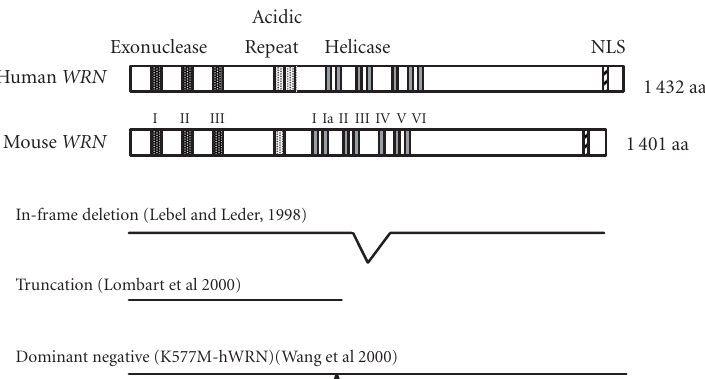
Figure 4. Mouse models of Werner syndrome. Structures of human and mouse WRN proteins and the alterations in the WRN gene product in the three mouse models of WS are shown.